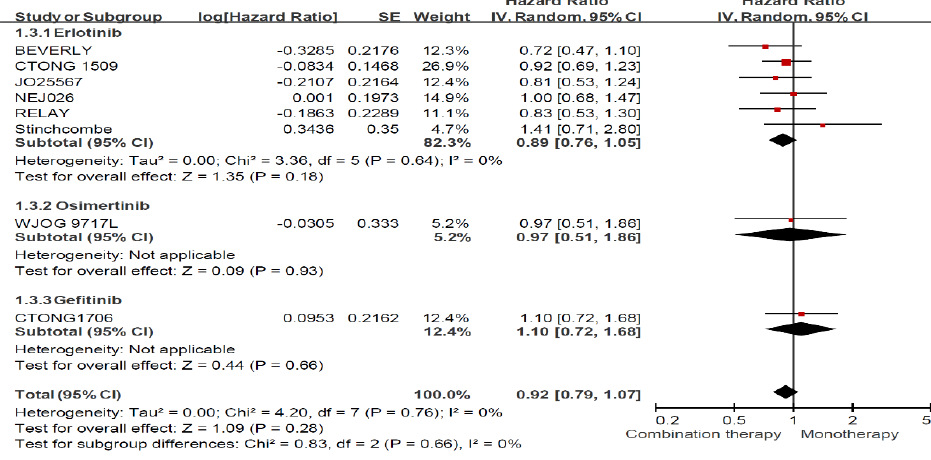
Figure A2. Forest plot and pooled hazard ratio for OS.